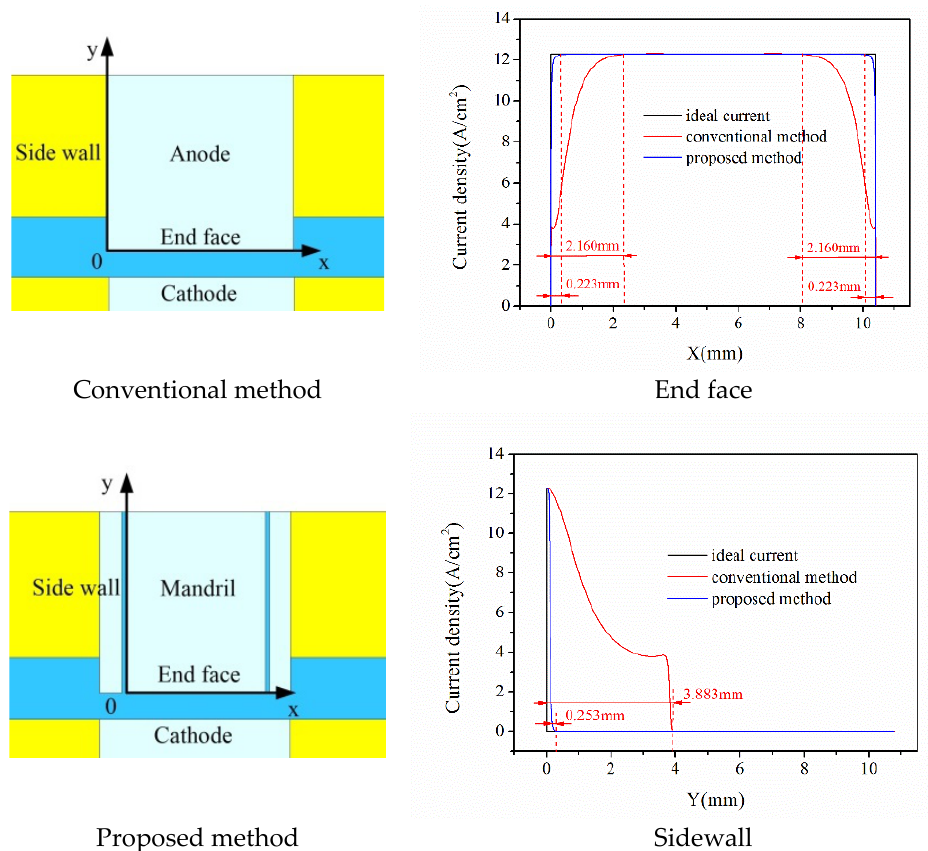
Figure 10. The current density distribution on the contour of the workpiece ( v = 0.1 mm/min).